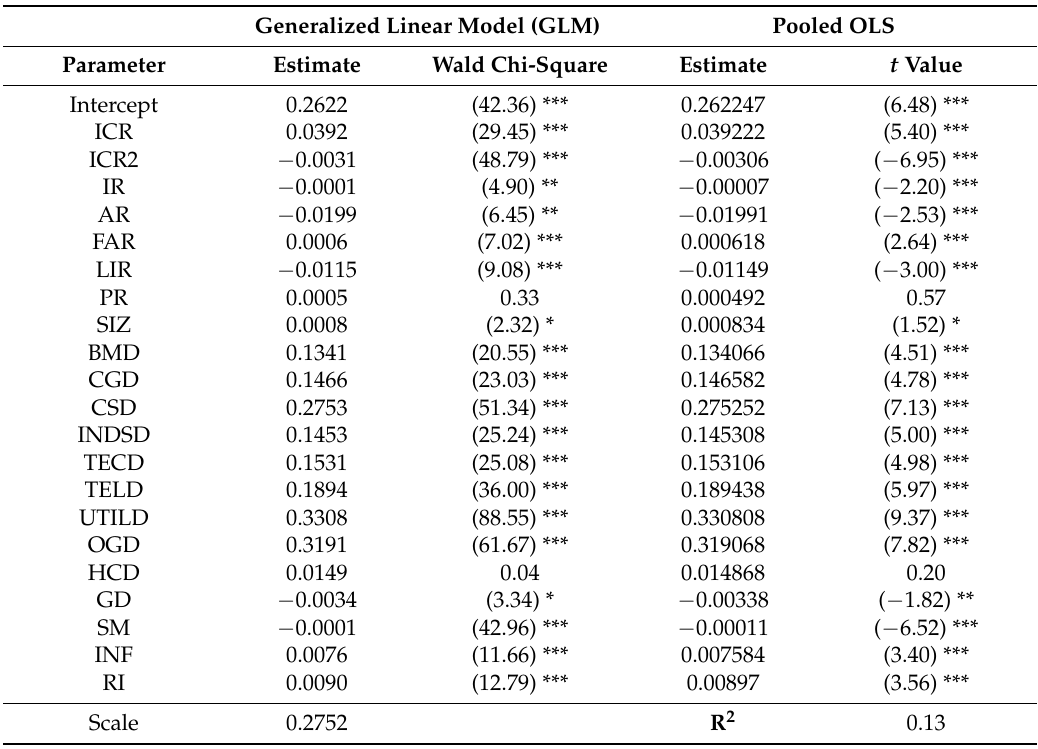
Table 5. Influence of rating scales on the debt maturity